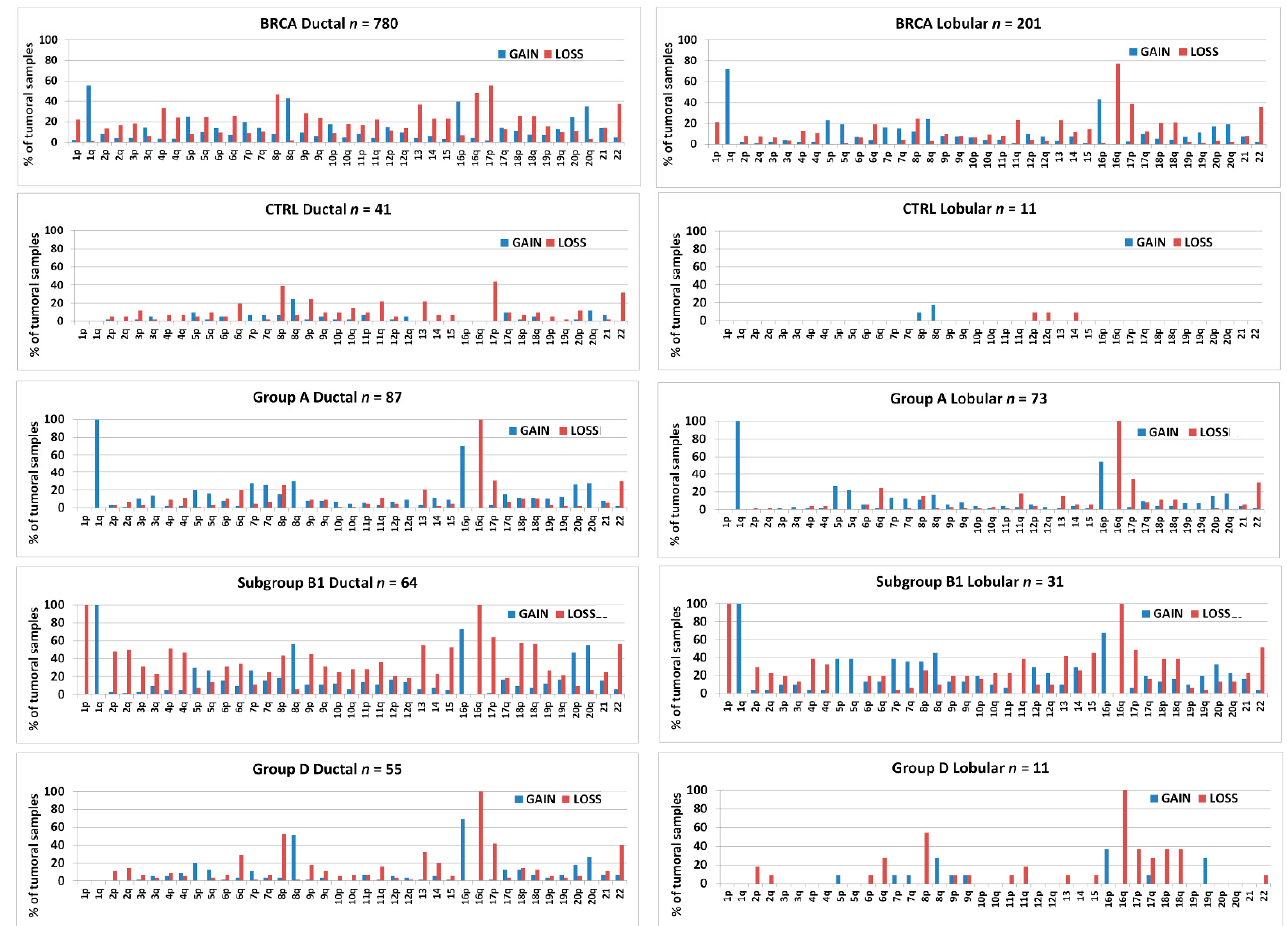
Figure 14. Bar graphs showing the percentage of samples bearing arm-level gains or losses in chromosomes 1–22 in invasive ductal or lobular breast carcinomas or in the different 1,16-chromogroups formed with invasive ductal carcinomas or invasive lobular carcinomas, as indicated in each graphs. The number of samples ( n ) in each chromogroup is reported in the corresponding graph.